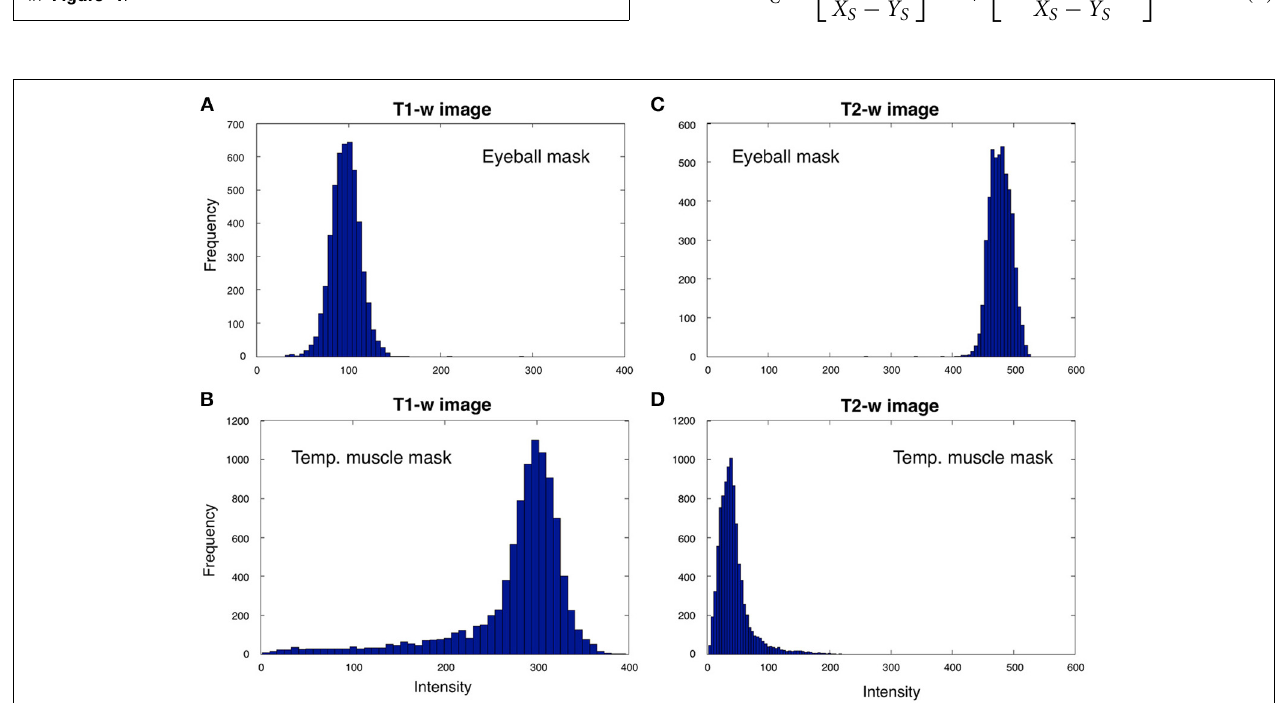
FIGURE 4 | T1-w and T2-w intensities for the eyeball and temporal muscle masks. We analyzed T1-w and T2-w intensities within the eyeball and temporal muscle masks for Subject 30 of the KIRBY21 database. The eyeball mask values for the T1-w image (A) are always lower than the ones in the temporal muscle mask (B) , whereas eyeball mask values in T2-w image